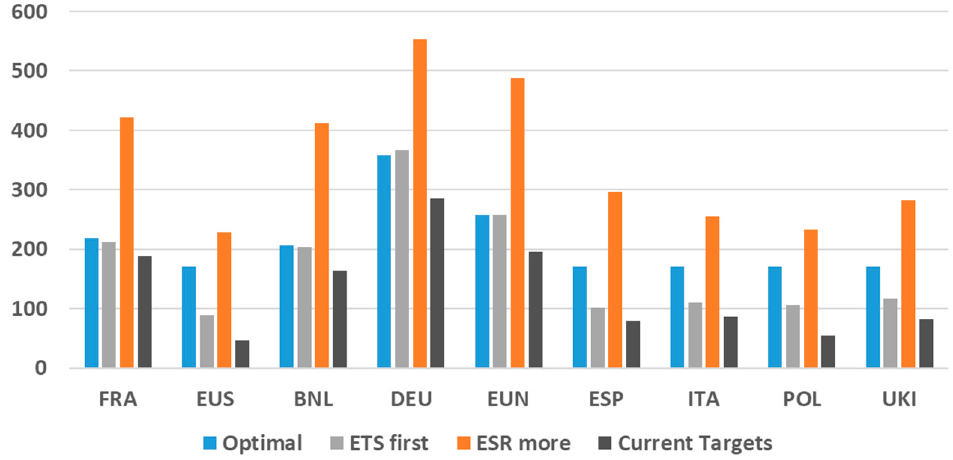
Figure A6. EU27 + UK regional absolute Non-ETS CO 2 prices in 2030 [€2020].